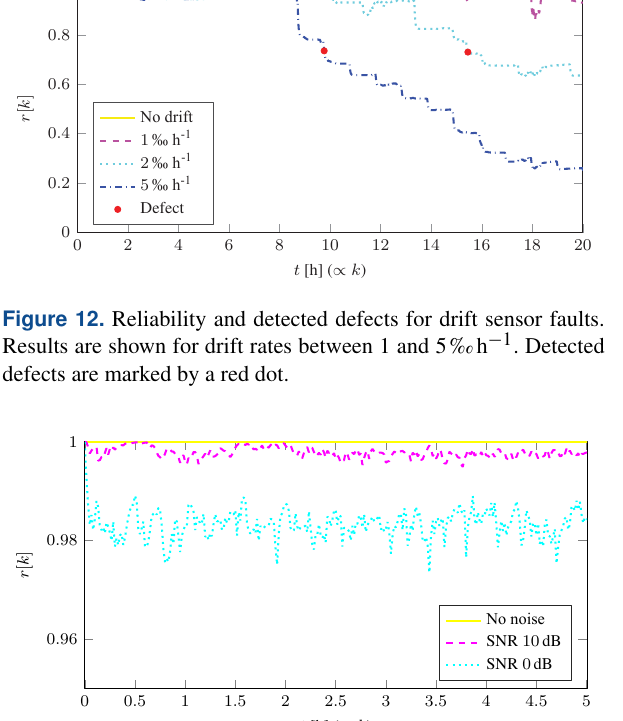
Figure 13. Reliability and detected defects for noise sensor faults. The evaluated signals contain additive zero-mean Gaussian noise with signal-to-noise ratios (SNR) of 10 and 0dB. No defect is de-